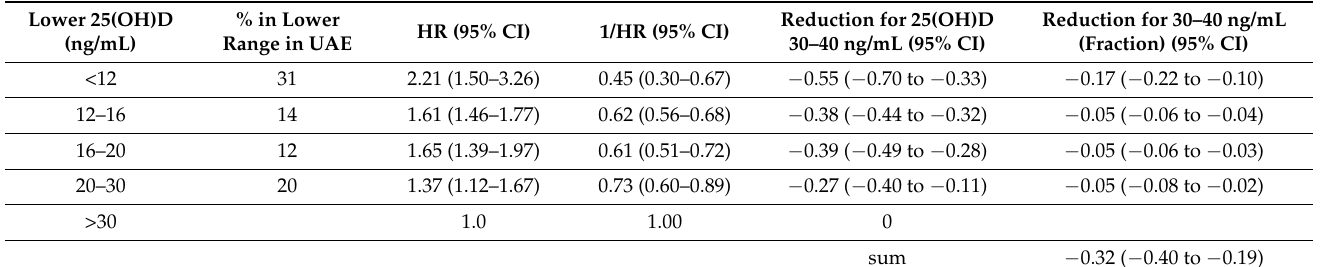
Table 6. Estimate of reduction in CVD mortality rate in the UAE by raising minimum 25(OH)D concentration to 30 ng/mL using 25(OH)D data from [85] and results from northern Europe [78].